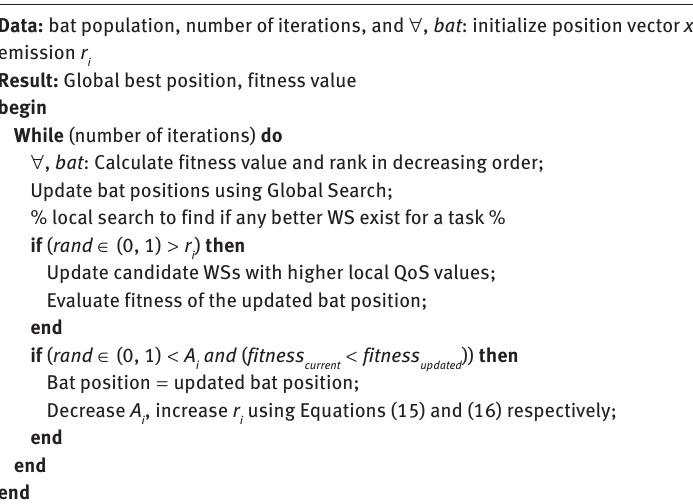
Algorithm 1: BAT Algorithm for WS